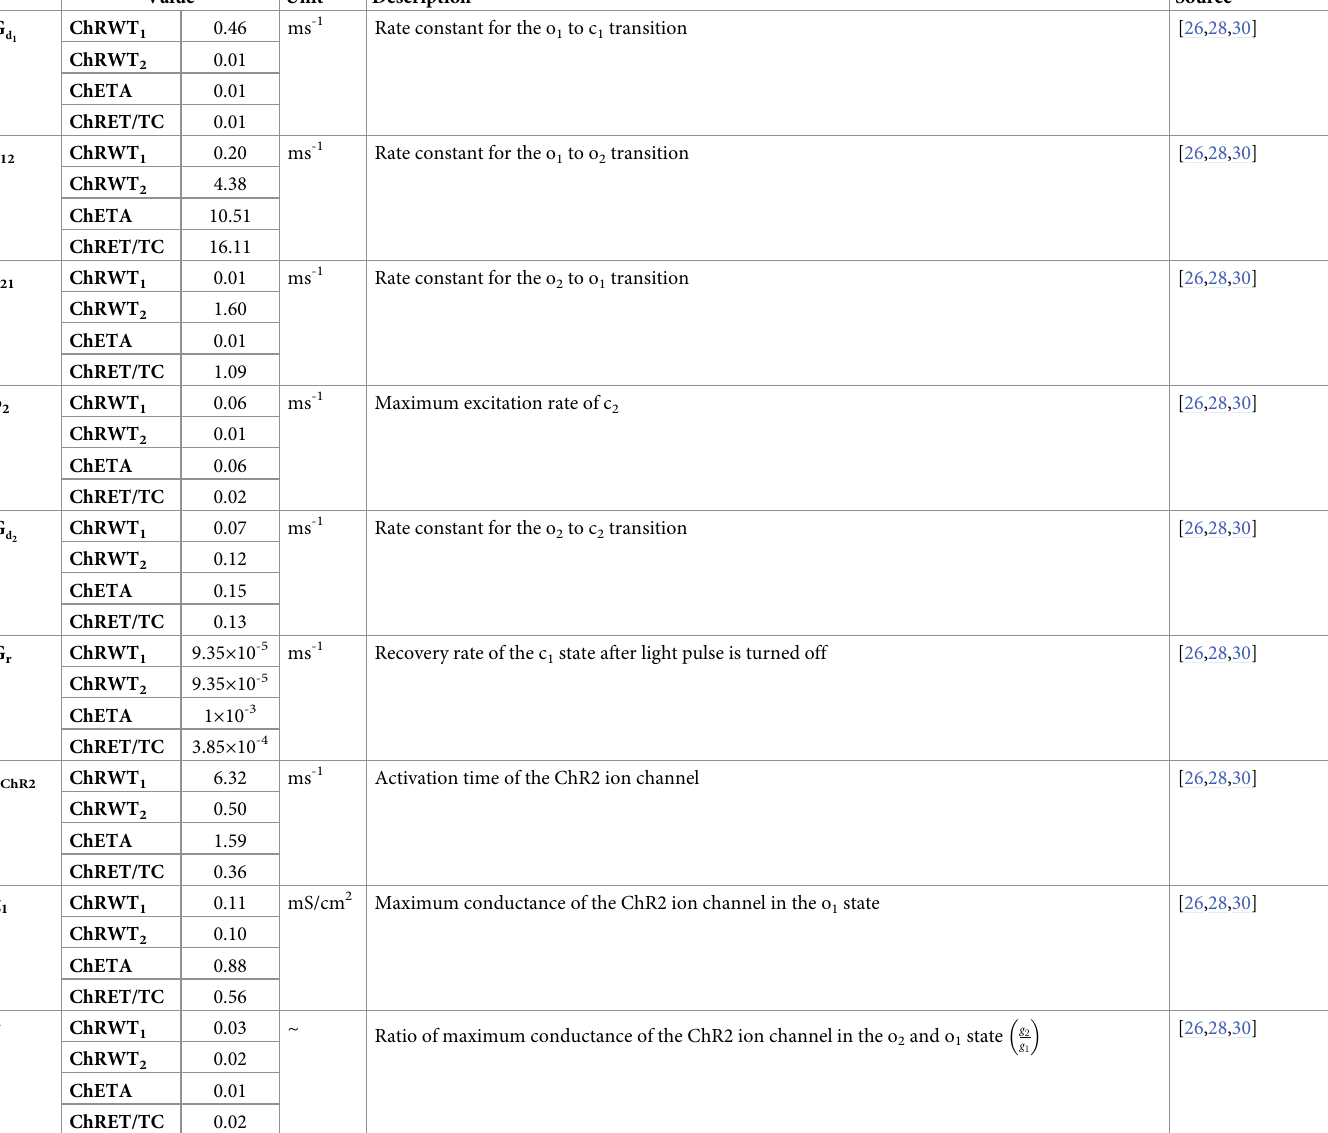
in detail in later sections. G is a diagonal matrix of diffusion rate components of the stochastic processes (noise) associated with state variables. The Brownian motion vector is denoted as d ω . The components of the G matrix are generally determined by the rate parameters of the deterministic part of the SDE, which lead to a state-dependent multiplicative noise in the sys- tem [32,44]. In calcium dynamics, the source of stochasticity is mainly attributed to the aggre- gation of a small number of IP R channels in clusters, which leads to the formation of intra- 3 cluster Ca 2+ blips (resulting from random opening of a single IP R) or Ca 2+ puffs and sparks 3 (from the concurrent opening of a large number of IP Rs within a cluster). When 3